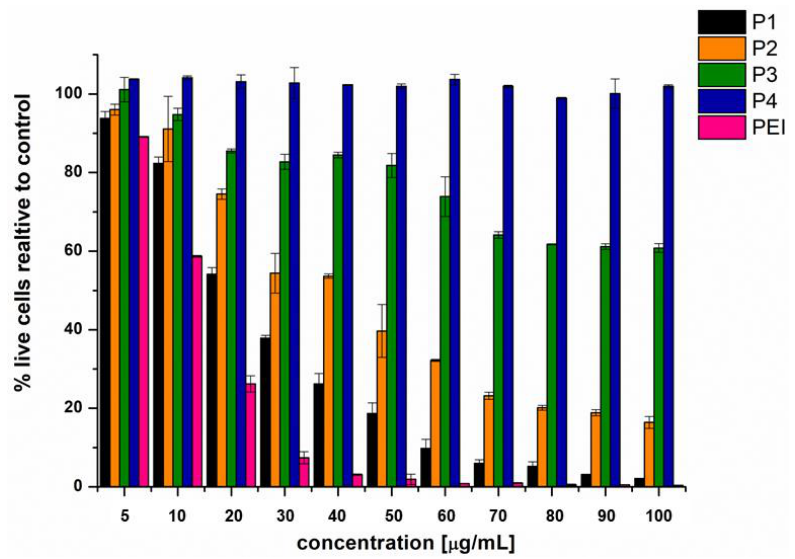
Figure 7. The cytotoxicity assay of the tested polymers. The assays were performed with HT-1080 cells. The results are presented as a % of cells surviving in the presence of the star polymers (P1 – P4, Table 1) and branched polyethyleneimine (PEI) at increasing